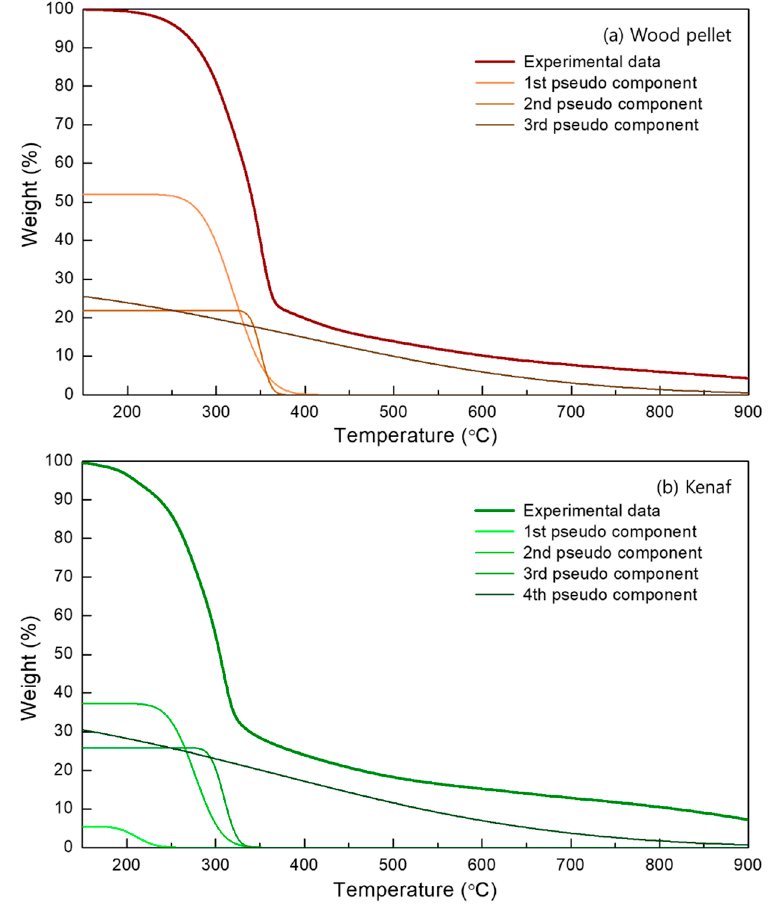
Figure 5. Weight loss of the pseudocomponents; ( a ) wood pellets and ( b ) kenaf.